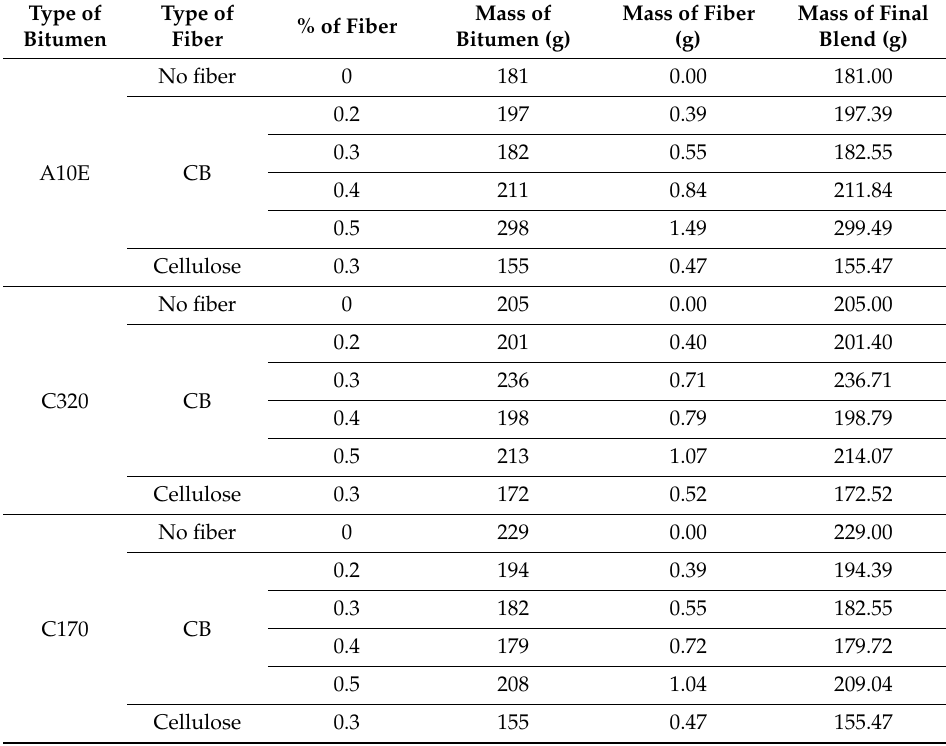
Table 2. Blending approach 1 for bitumen modified with cellulose fiber and cigarette butts.